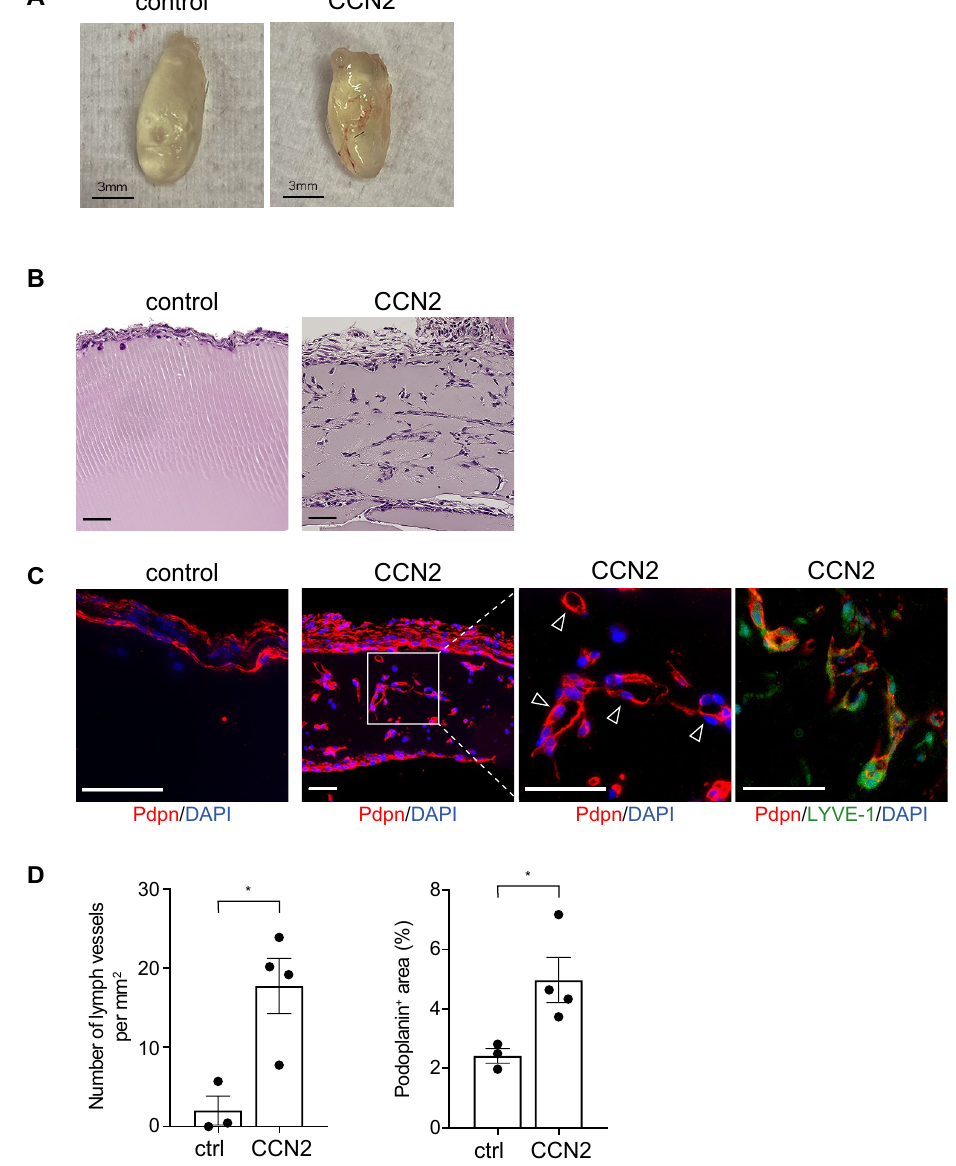
Figure 1. CCN2 enhances lymphangiogenesis in in vivo Matrigel plug assay. Matrigel and recombinant CCN2 were mixed and injected subcutaneously back of the mice. Control mice were injected with Matrigel and PBS mixture. ( A ) Images of Matrigel removed 7 days after injection. Scale bars: 3 mm. ( B ) HE-stained sections of Matrigel. Bars: 50 µm. ( C ) Immunostaining of Podoplanin and LYVE-1. Arrowheads indicate Podoplanin- positive vessels in the CCN2 gel. Bars: 50 µm. ( D ) Number of Podoplanin-positive vessels per mm 2 and the ratio of the Podoplanin-positive area to the whole area. Student t test, * p <